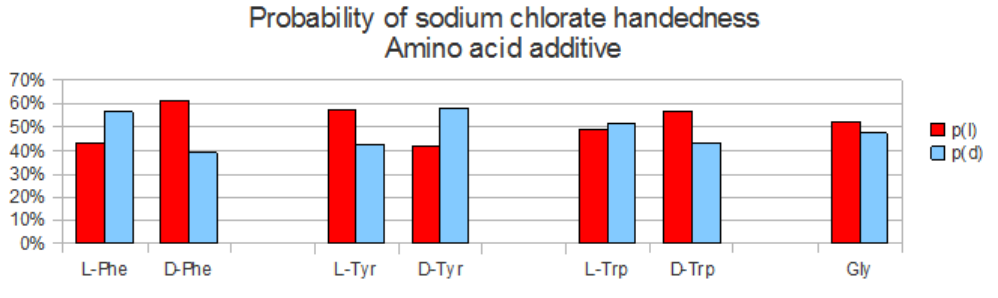
Figure 3. True proportion or probability of sodium chlorate handedness, (l) vs. (d), as a function of added hydrophobic amino acid. Both handedness are equiprobable, up to the statistical error, in the case of Gly, whereas with chiral amino acids ( L or D ) Phe, Tyr and Trp additives, there is a significant bias in the proportion towards one or other handedness that depends on the chiral sign of the amino acid and on the amino acid